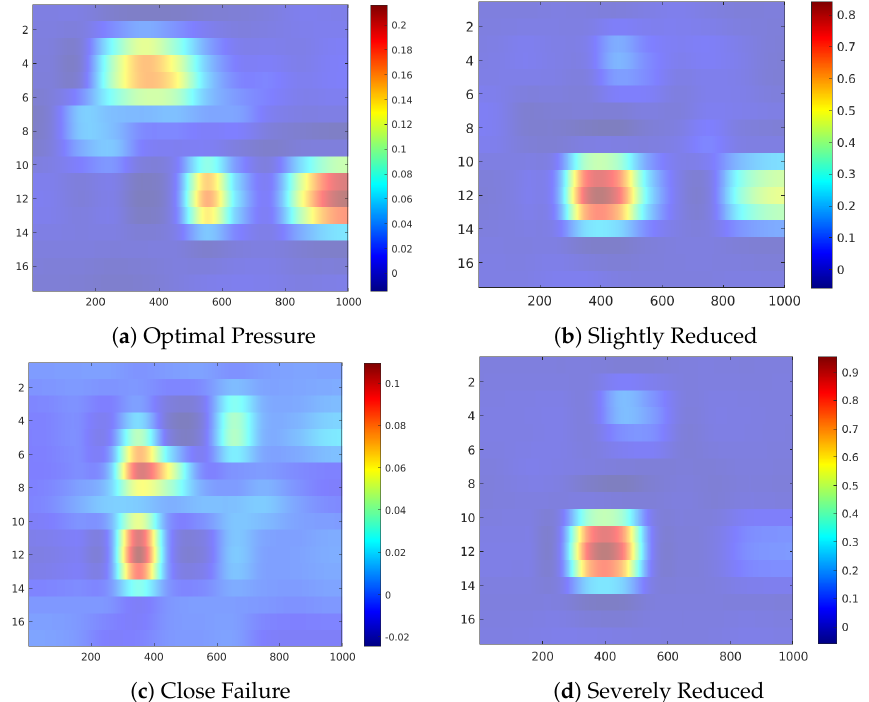
Figure 11. Feature attribution heatmap for the Hydraulic Accumulator condition.